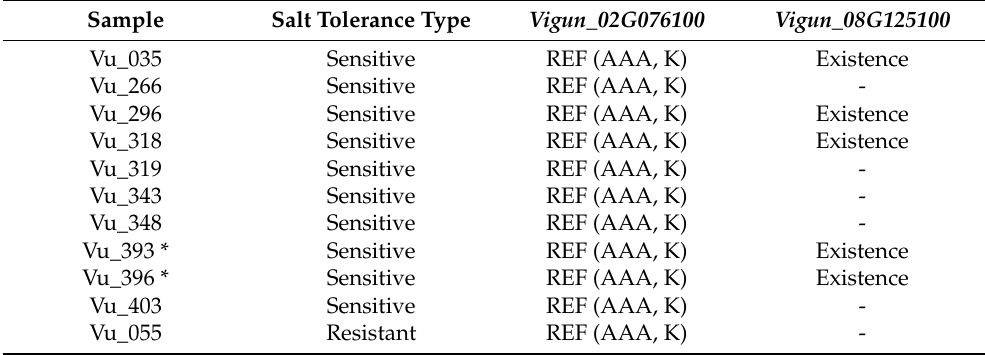
Table 2. Validation and comparison of the variation in the two candidate genes using 20 cowpea